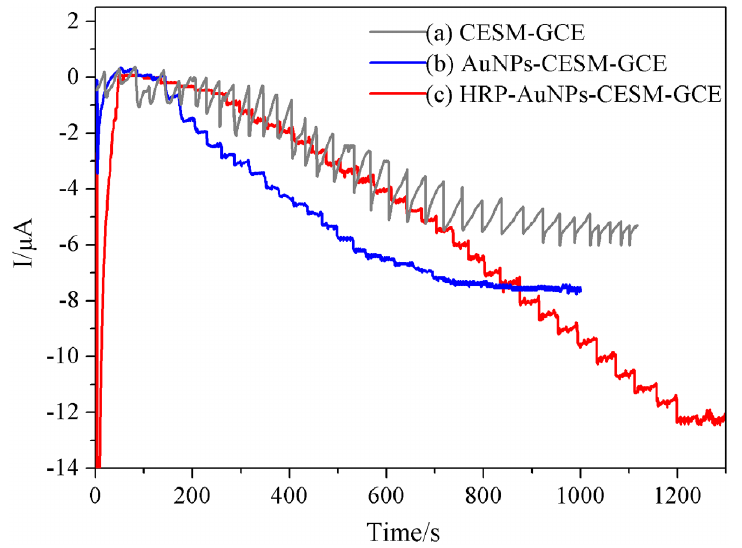
Fig 6. Typical amperometric responses of the different modified electrodes. The applied potential was -0.2 V vs. SCE in 0.1 M PBS solution (pH =